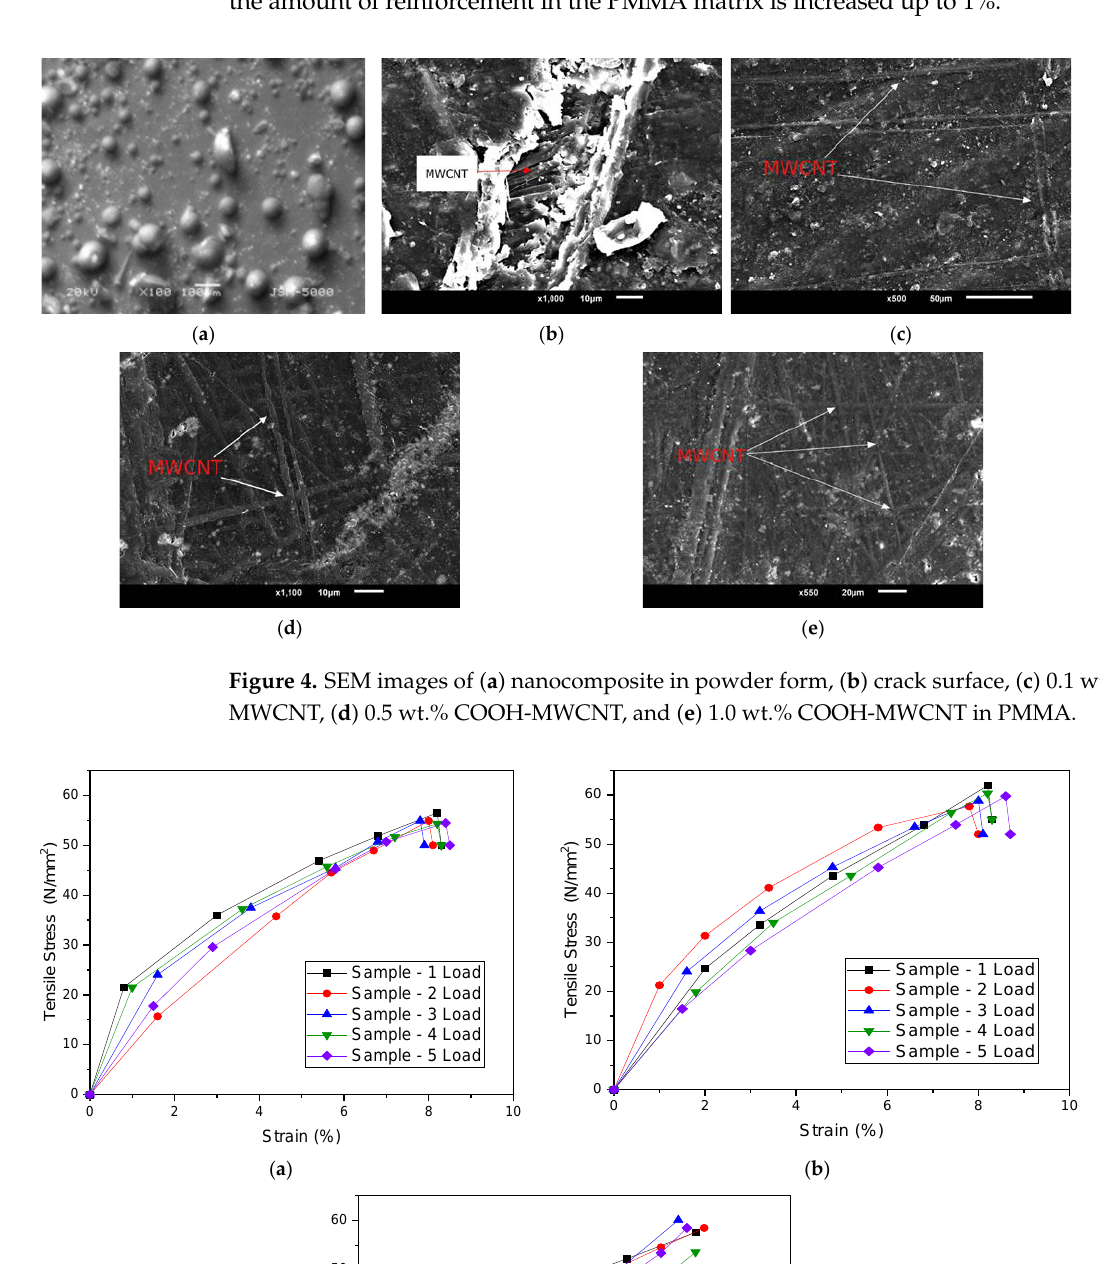
( c ) Figure 3. Specimen testing setup for ( a ) tensile test, ( b ) flexural test, and ( c ) tested specimens. 4. Results and Discussion